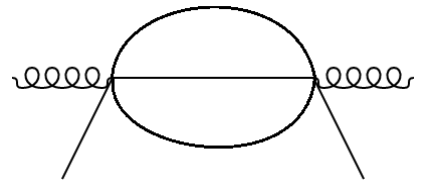
Figure 4 . While the theory given by equation (3.10) is not itself unhealthy, pathological terms are generated through the above two loop diagram, leading it to induce theories of the type studied in section